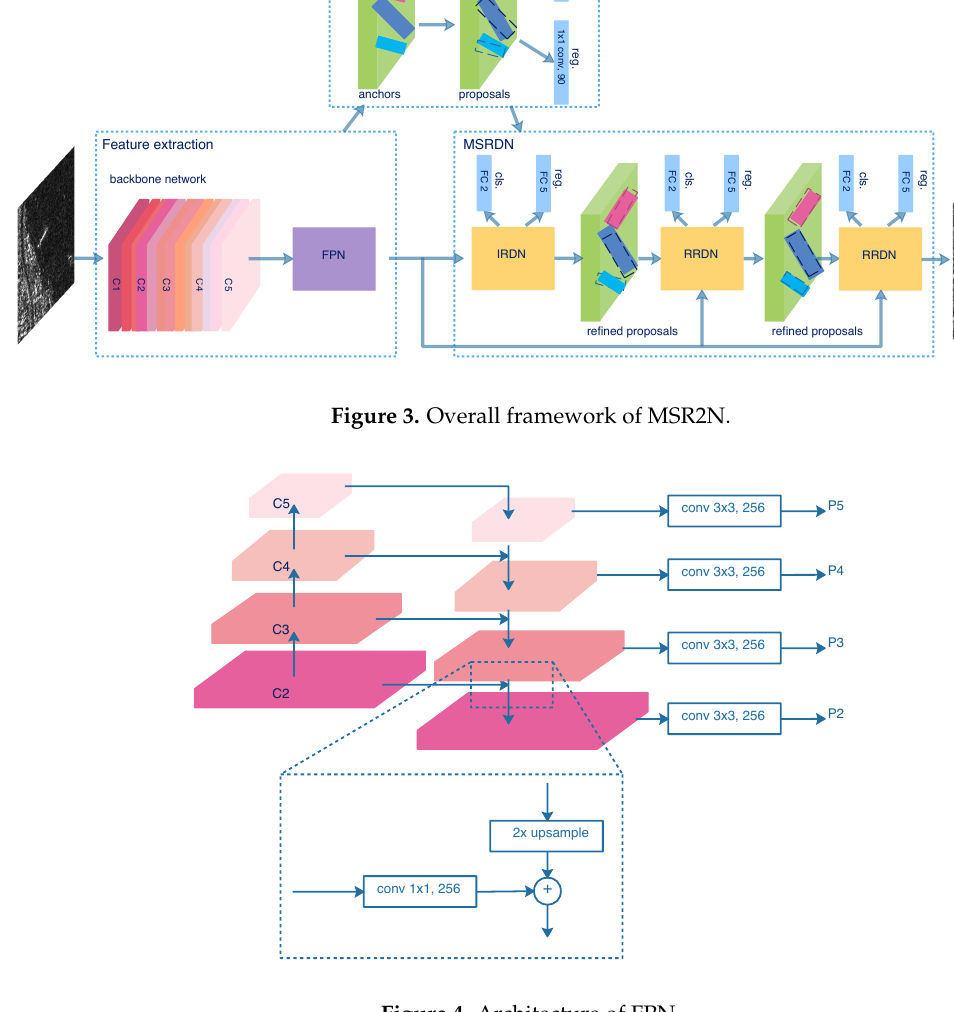
Figure 4. Architecture of